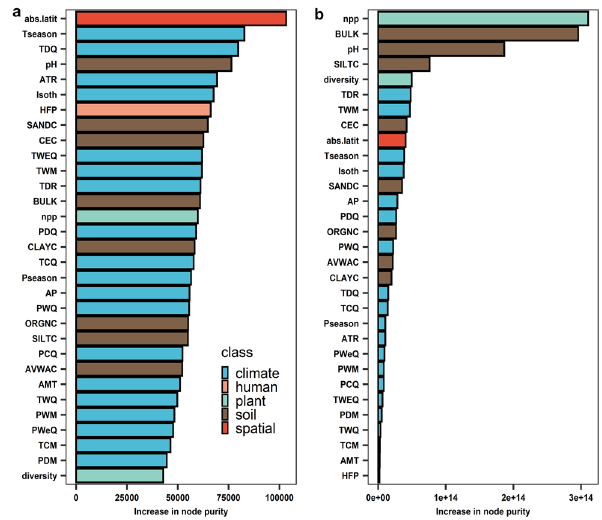
Fig. 2 Variable importance (increase in node purity) of random forests run with all 31 predictors. a Soil seed bank diversity; b Density. abs.latit, absolute latitude; AMT, annual mean temperature; AP, annual precipitation; ATR, annual temperature range; AVWAC, available water capacity (%); BULK, bulk density; CEC, cation exchange capacity; CLAYC, clay (mass %); diversity, plant diversity; HFP, human footprint; Isoth, isothermality; npp, plant productivity (net primary production); ORGNC, organic carbon content; PCQ, precipitation of coldest quarter; PDM, precipitation of driest month; PDQ, precipitation of driest quarter; pH, pH measured in water; Pseason, precipitation seasonality (coef fi cient of variation); PWeQ, precipitation of wettest quarter; PWM, precipitation of wettest month; PWQ, precipitation of warmest quarter; SANDC, sand (mass %); SILTC, silt (mass %); TCM, min temperature of coldest month; TCQ, mean temperature of coldest quarter; TDQ, mean temperature of driest quarter; TDR, mean diurnal range (mean of monthly (max temp – min temp)); Tseason, temperature seasonality (standard deviation *100); TWeQ, mean temperature of wettest quarter; TWM, max temperature of warmest month; TWQ, mean temperature of warmest